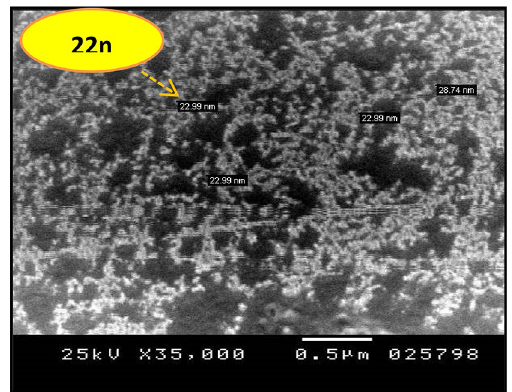
Figure 2. SEM image of Nanocellulose extracted from rice straw.